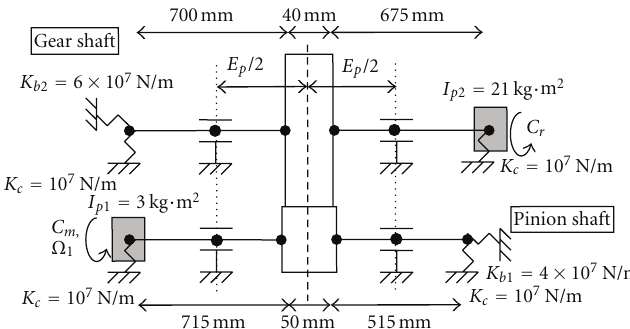
Figure 1: Model of the test-rig.